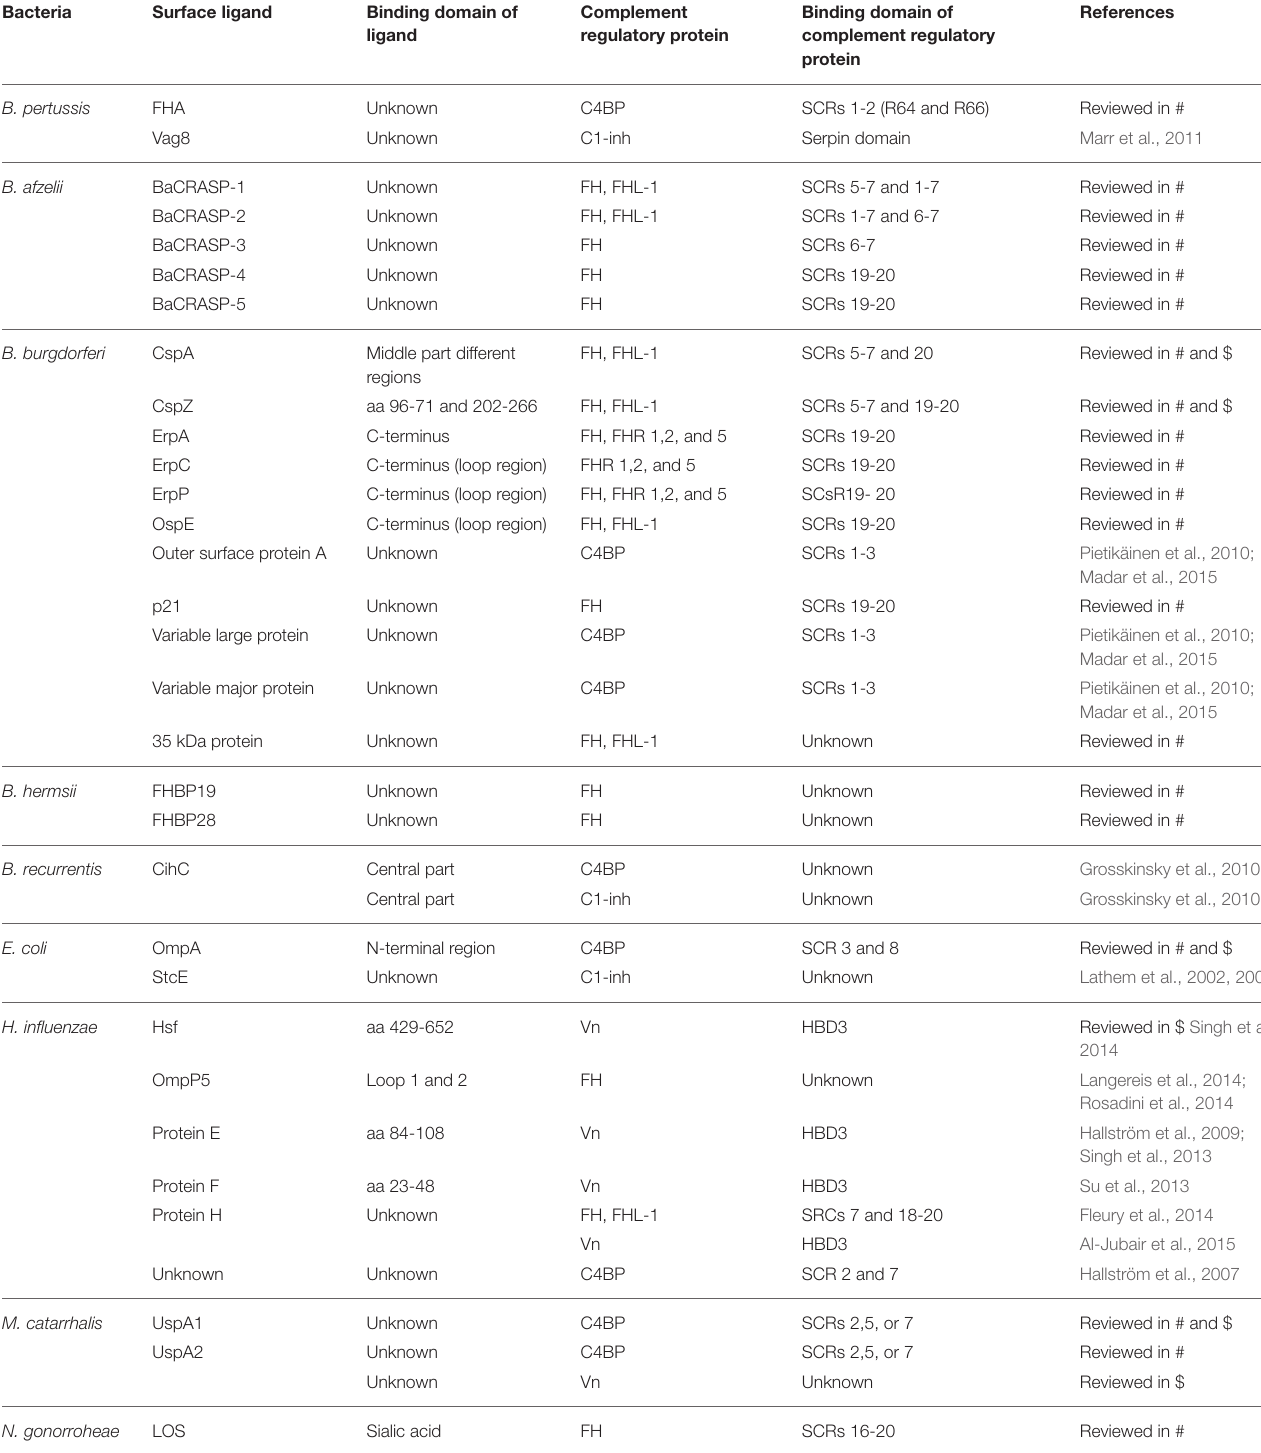
TABLE 2 | Overview of bacterial interactions with host complement regulatory proteins discussed in this review and reviewed in Kraiczy and Würzner (2006) (#) and Blom et al. (2009)